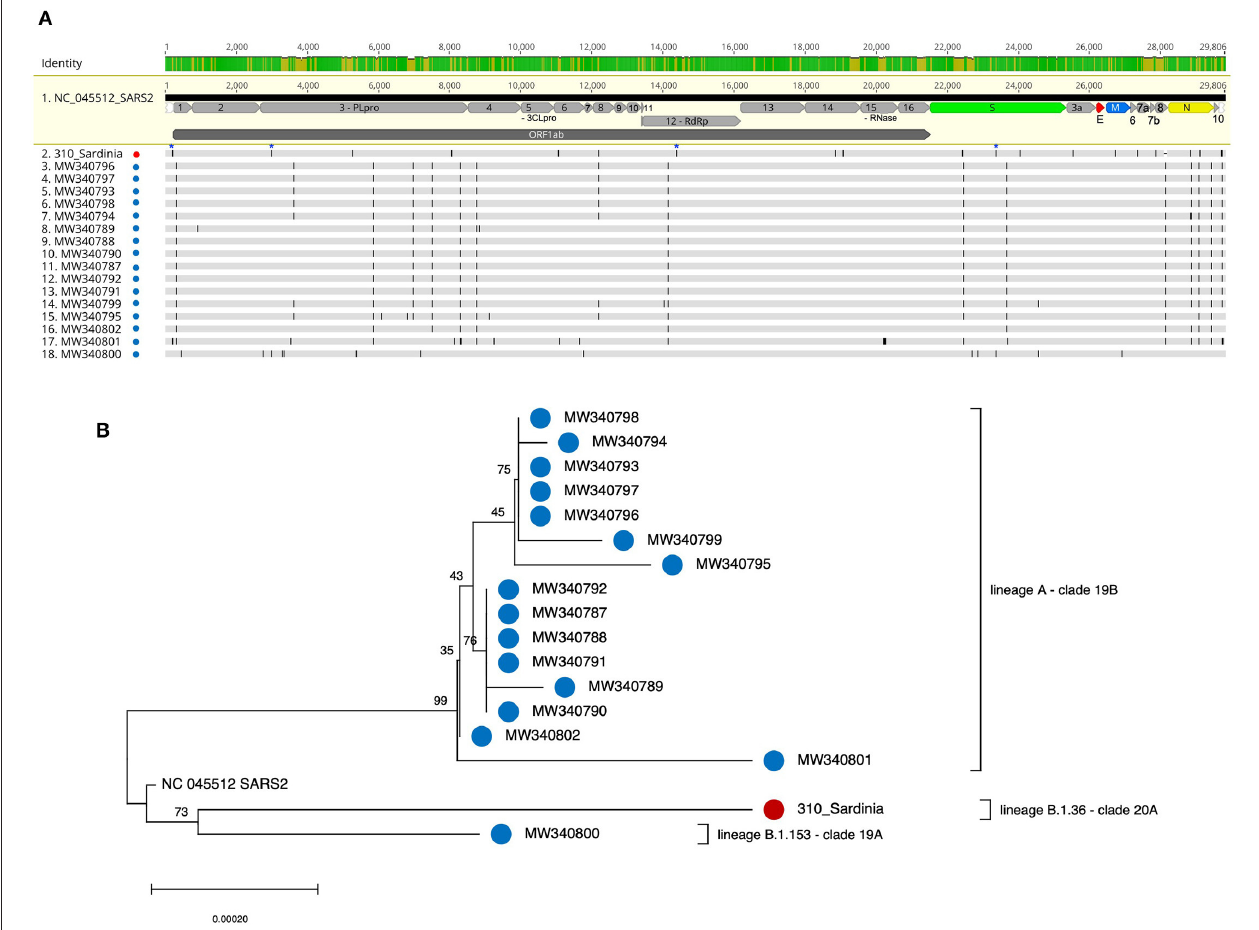
FIGURE 1 | Multiple alignment and phylogenetic tree of SARS-CoV-2 genomes from migrants arrived in Italy through the Libyan route. Viral genomes sequenced from nasopharyngeal swabs of positive migrants arrived at the harbors of Olbia (310 Sardinia NC_OL944327, this study: red dots) and Porto Empedocle (Sicily, (8): blue dots) were used to build a multiple sequence alignment (A) that was analyzed with the NJ method (B) , applying the pairwise deletion option. Phylogenies were tested with 1000 bootstrap replicates. The SARS-CoV-2 reference sequence (NC_045512) was also